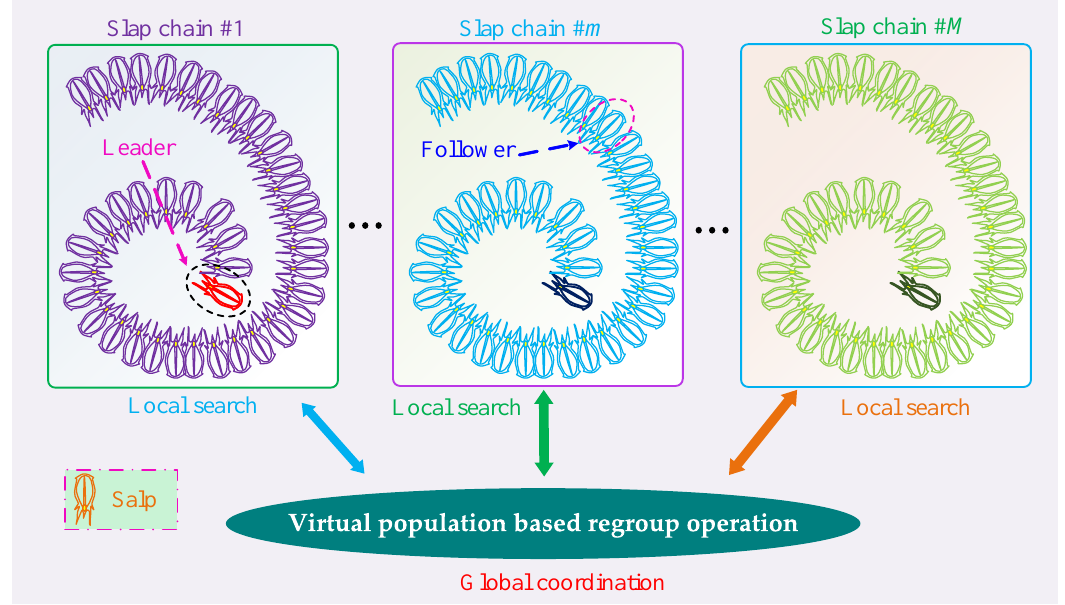
Figure 2. Optimization framework of memetic salp swarm algorithm (MSSA).